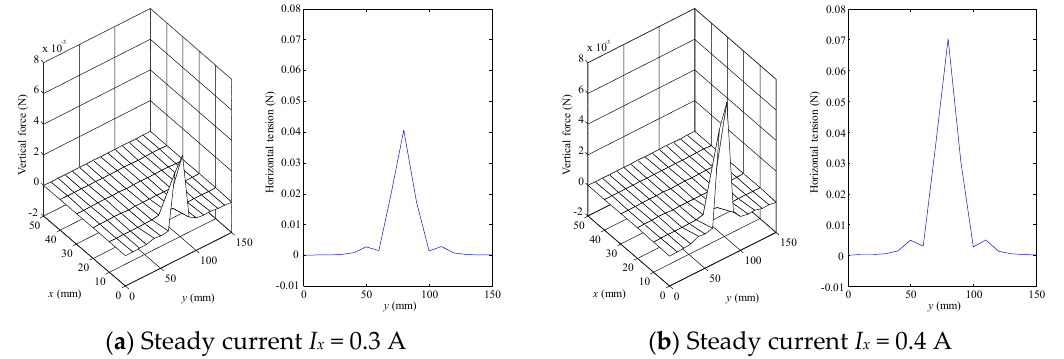
Figure 5. Analysis result of magnetic field (horizontal electromagnet).